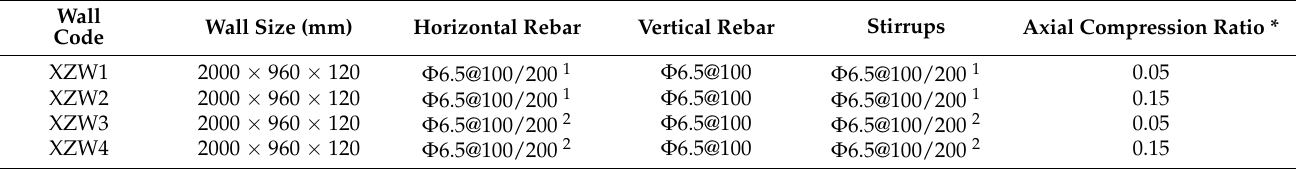
Table 2. Reinforcements of the